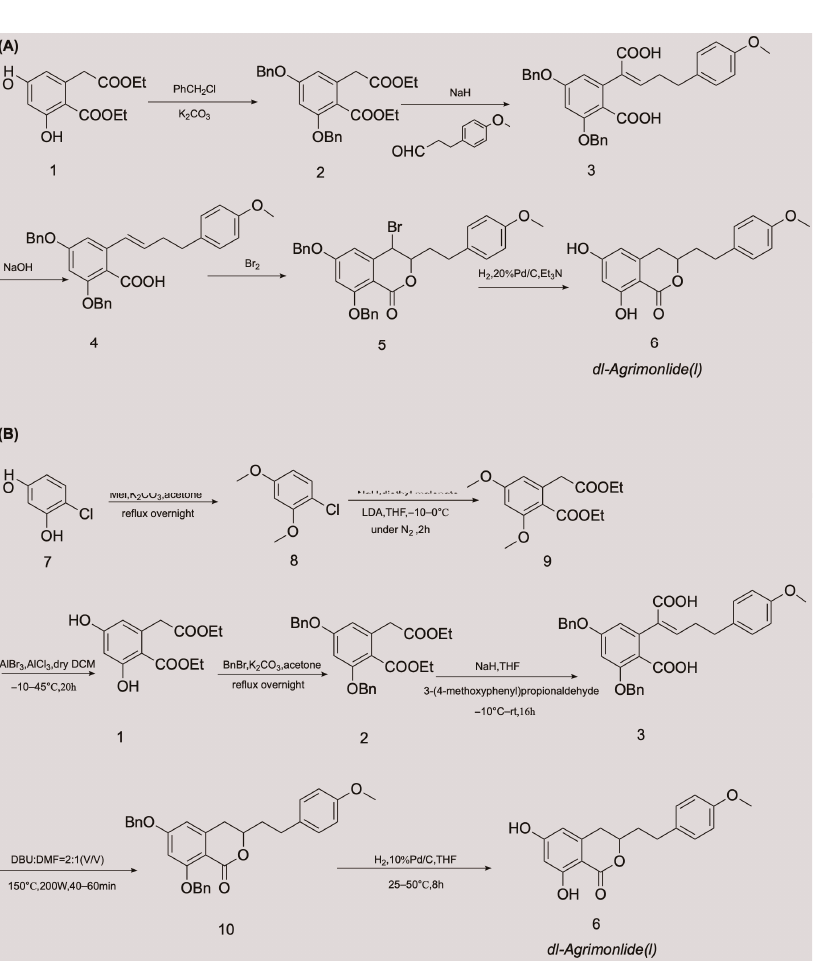
Table 2. Physicochemical properties of AM.